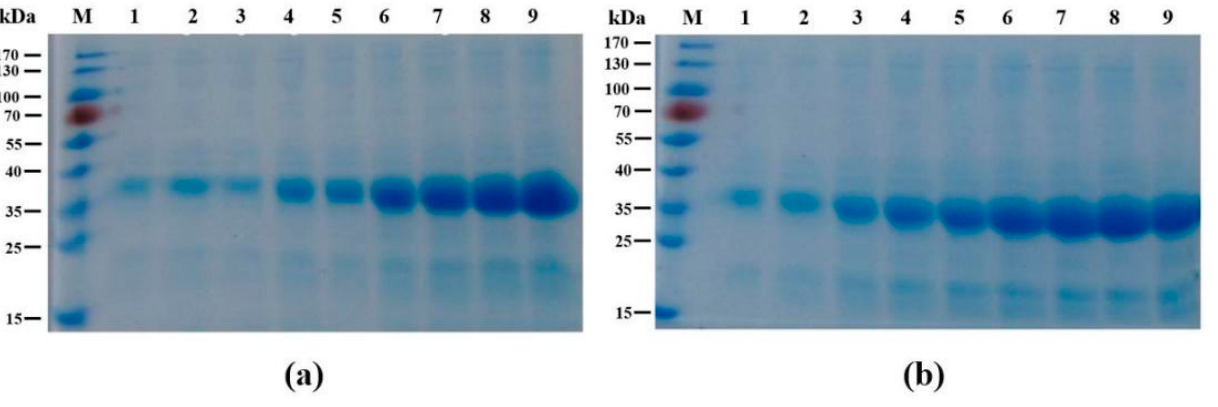
Figure 6. SDS-PAGE analysis of culture supernatant obtained during cultivation in 30 L and 100 L fermenters. ( a ) Raw glycerol fed-batch fermentations in a 30 L fermenter with an initial modified FM22 medium of 15 L. Lane M, Fermentas pre-stained protein ladder 26616 (Fermentas, Burlington, Canada); lanes 1–9, 15 μ L of culture supernatant at 41 h, 49 h, 65 h, 72 h, 88 h, 97 h, 113 h, 121 h, and 136 h, respectively. ( b ) Raw glycerol fed-batch fermentations in a 100 L fermenter with a 45 L initial modified FM22 medium. Lane M, low-molecular-weight marker; lanes 1–9, 15 μ L of culture supernatant in a 100 L fermenter after 41 h, 49 h, 65 h, 72 h, 88 h, 97 h, 113 h, 121 h, and 136 h, respectively.